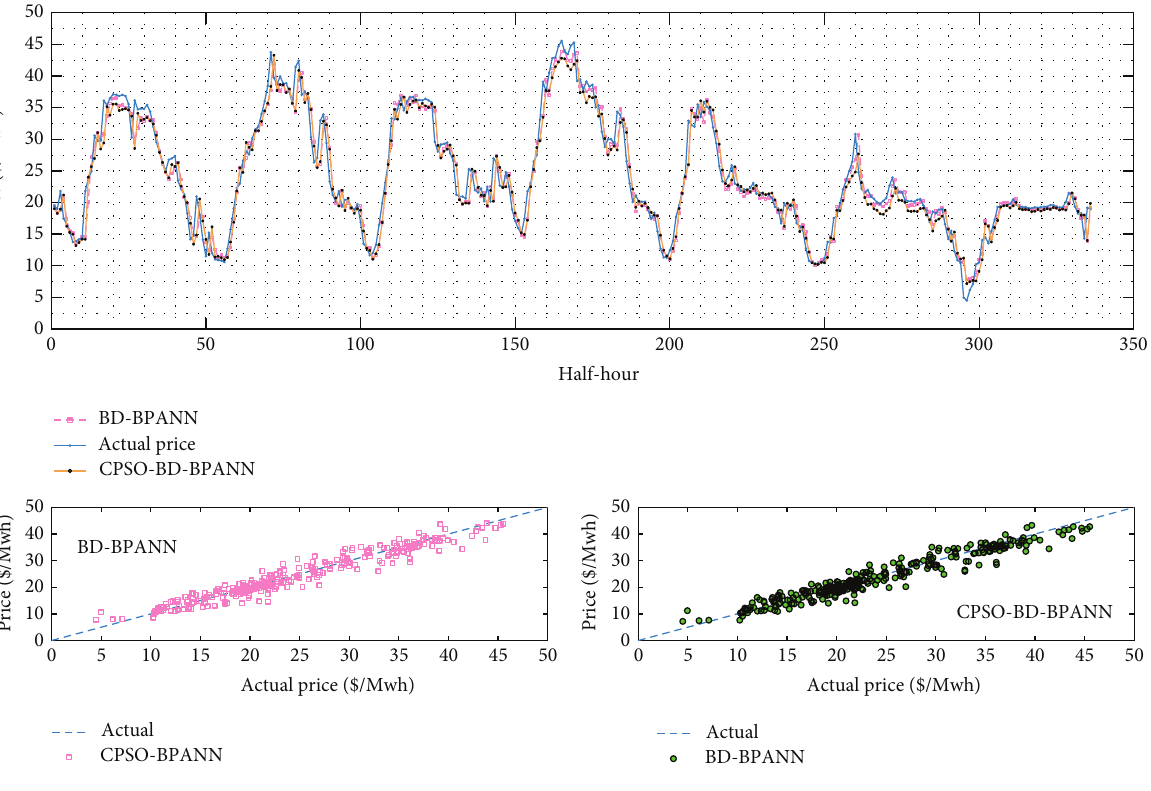
Figure 13: BD-BPANN and CPSO-BD-BPANN methods for case